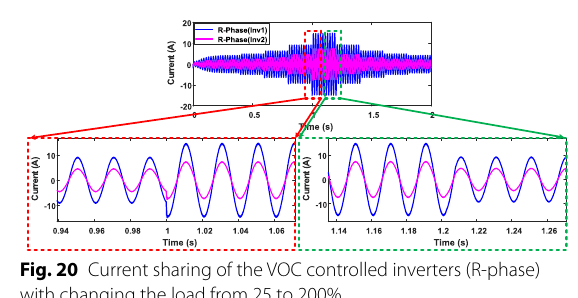
Fig. 20 Current sharing of the VOC controlled inverters (R-phase) with changing the load from 25 to 200%